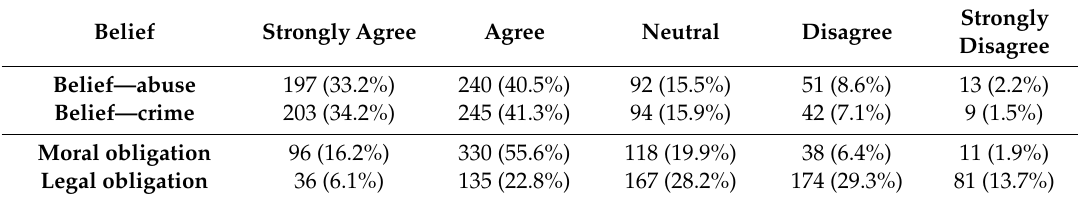
Table 3. Belief in the “link” and obligation to intervene in animal abuse cases.